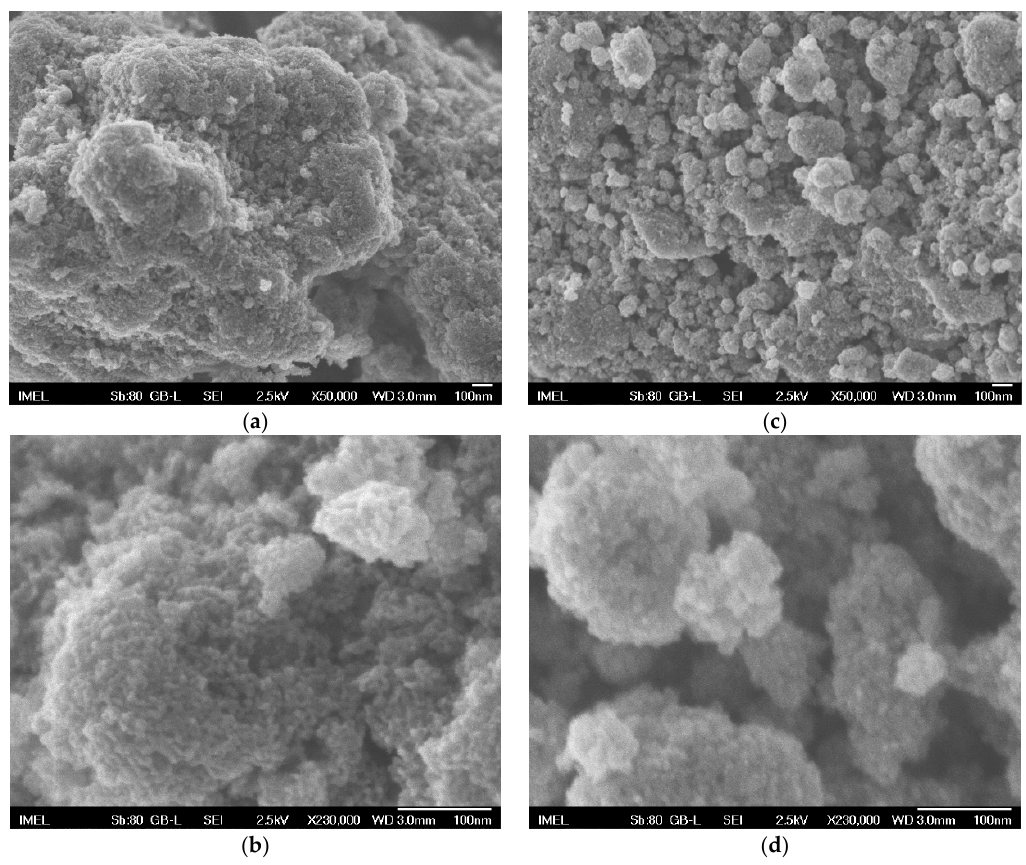
Figure 1. FE-SEM micrographs of ( a ), ( b ) Kronos vlp 7000 commercial powder, ( c , d ) N,S-TiO 2 lab-made powder.